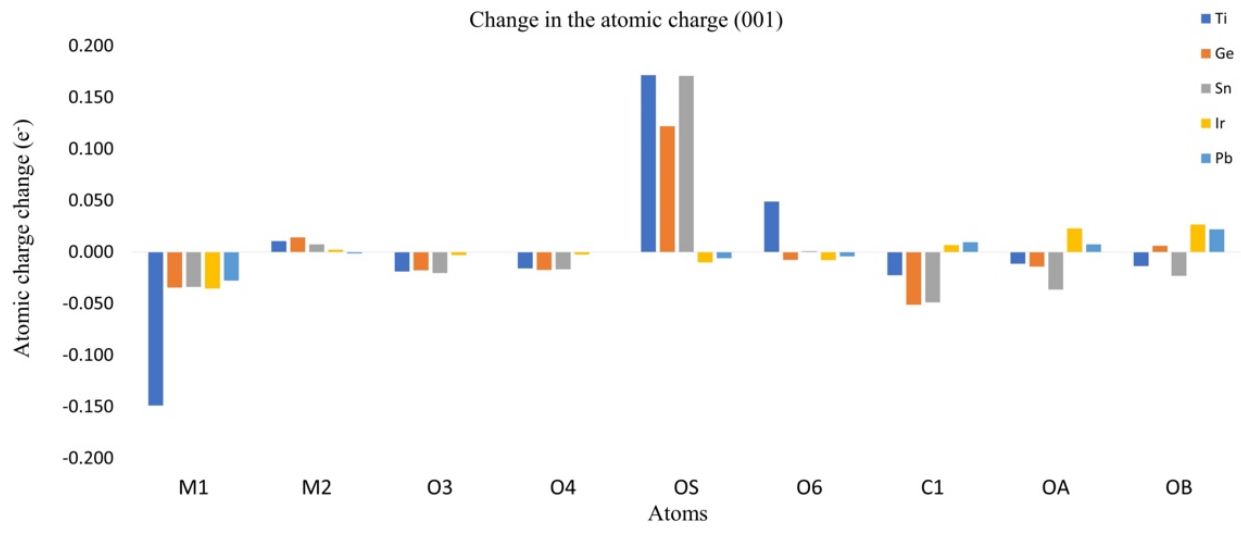
Figure 7. Atomic charge change for plane (001).